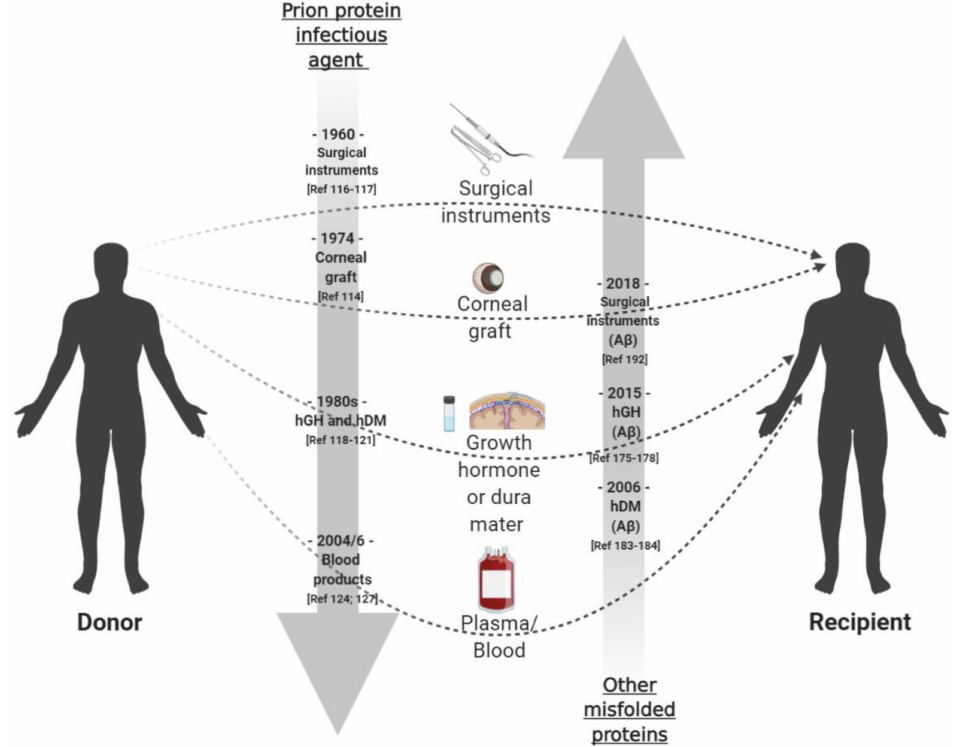
Figure 2. Schematic timeline (grey arrows) of the first reporting (as referenced) of acquired forms of Creutzfeldt-Jakob disease (CJD) and the possible human-to-human transmission of amyloid-beta (A β ) pathology. The routes of exposure to prion protein aggregates, resulting in iatrogenic CJD (iCJD), are well-documented and include medical interventions such as cadaveric human growth hormone (hGH), cadaveric dura mater grafting (hGH), and through a small number of neurosur- gical procedures. The recent re-examination of brain tissue from iCJD cases have suggested that A β neuropathology may also spread through similar routes of exposure. Concerns that the A β neuropathology may be a consequence of cross-seeding with co-existing prion protein aggregates were discounted following the observation of A β neuropathology in a proportion of hGH recipients who died from causes unrelated to CJD. While secondary transmission of variant CJD (vCJD) via transfusion medicine has been reported, no such instances of transmission have been identified for other pathogenic proteins. However, as the timeline for the identification of possible iatro- genic transmission of A β neuropathology occurs decades after that of acquired forms of CJD, the possibility of the transmission A β neuropathology via transfusion medicine requires further investi- gation, particularly due to the high presence of A β that accumulates in cerebral blood vessels in the iCJD